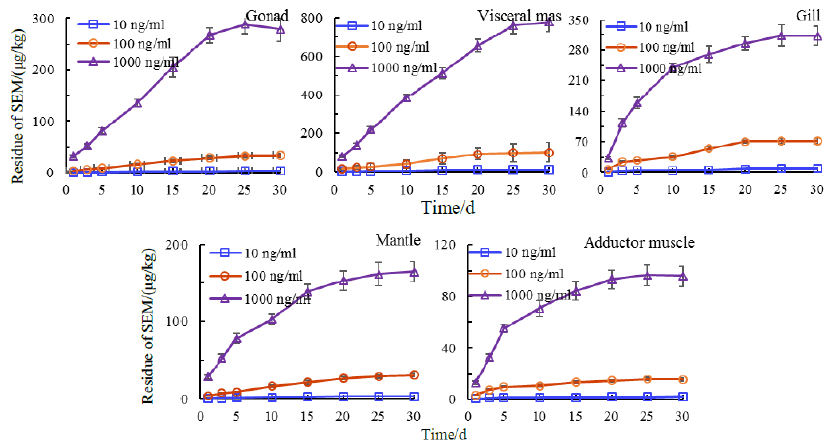
Figure 2. Proportion of tissue-bound semicarbazide in different scallop tissues. a,b mean values with different letters on vertical bars mean significant difference ( p < 0.05).